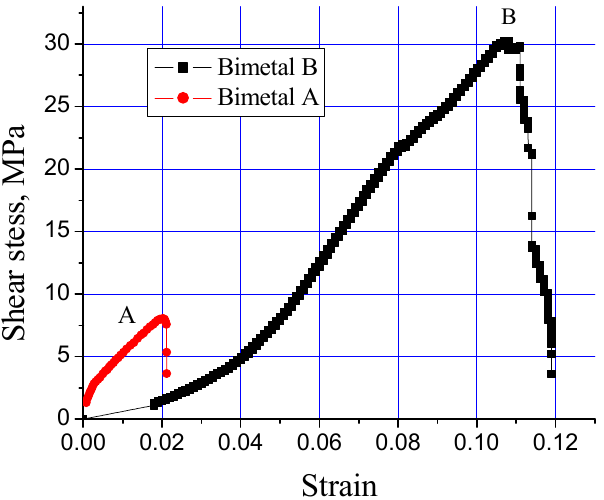
Figure 6. Effect of processing parameters on interfacial shear stress of Al-bearing alloy/carbon steel bimetallic composites, S0 and S1.